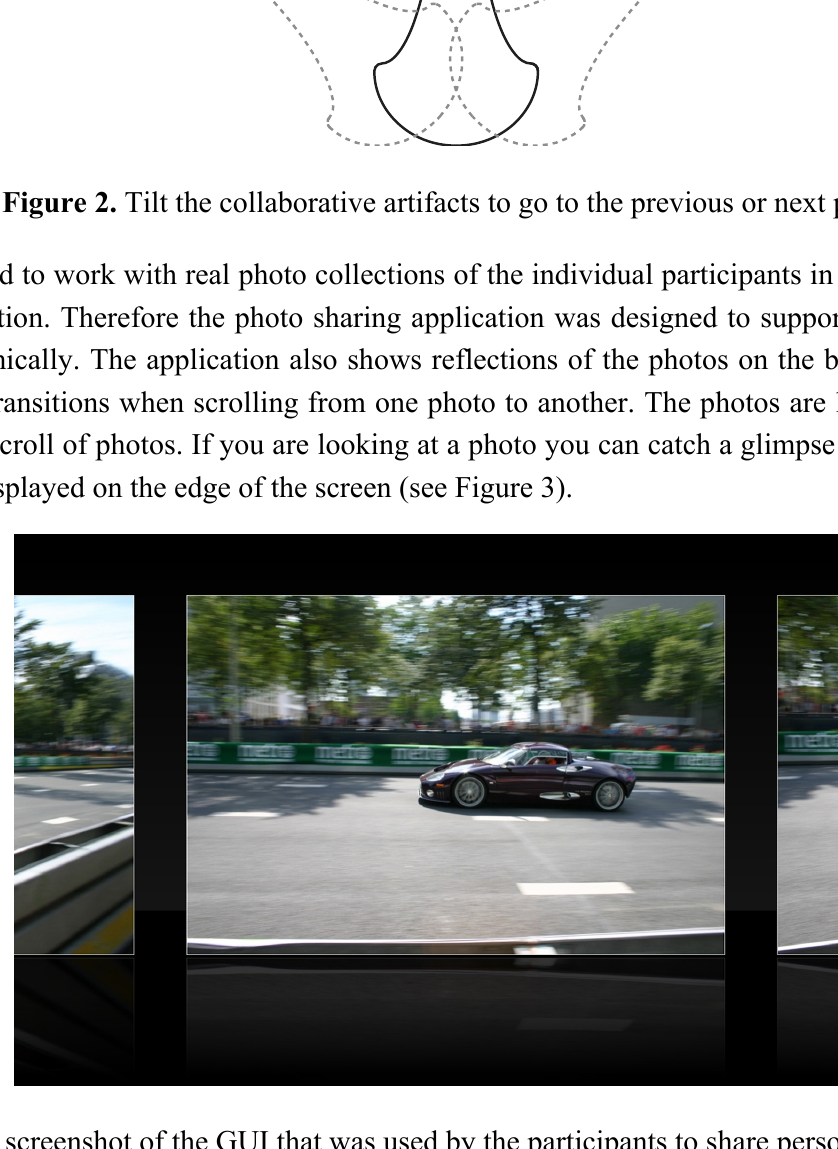
Figure 3. A screenshot of the GUI that was used by the participants to share personal digital